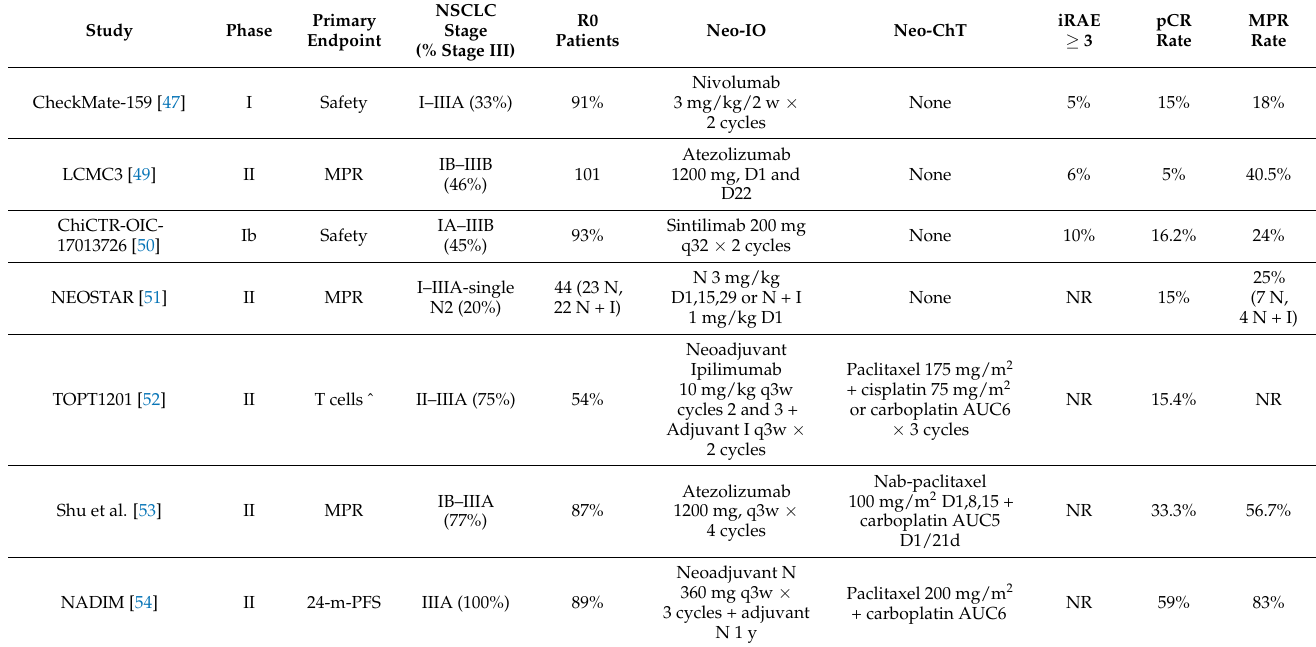
Table 2. Neoadjuvant studies with immunotherapy +/ − chemotherapy in stage III-N2